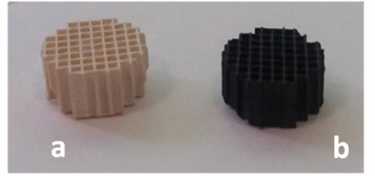
Figure 7. ( a ) Naked alumina wash-coated cordierite honeycomb monolith and ( b ) the corresponding monolith catalyst after impregnation with TiO 2 (14 wt%), Mn (5 wt%) and Pd (0.5